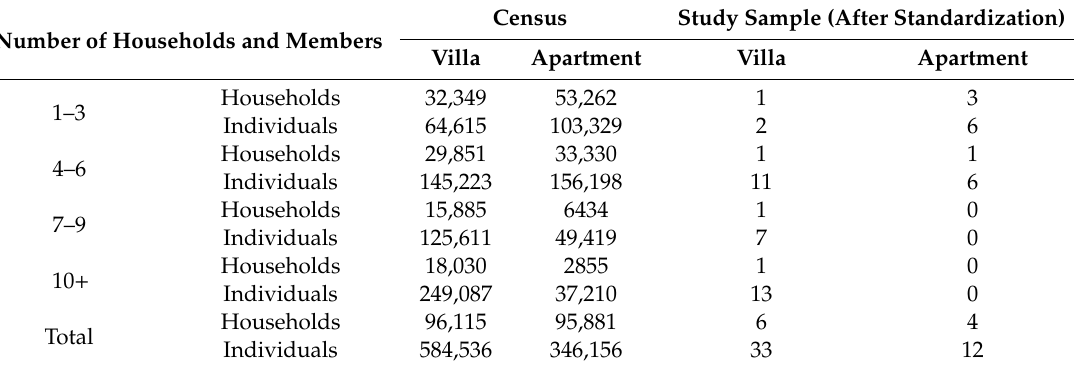
Table 3. Qatar households and individuals segregated by accommodation type and a number of occupants